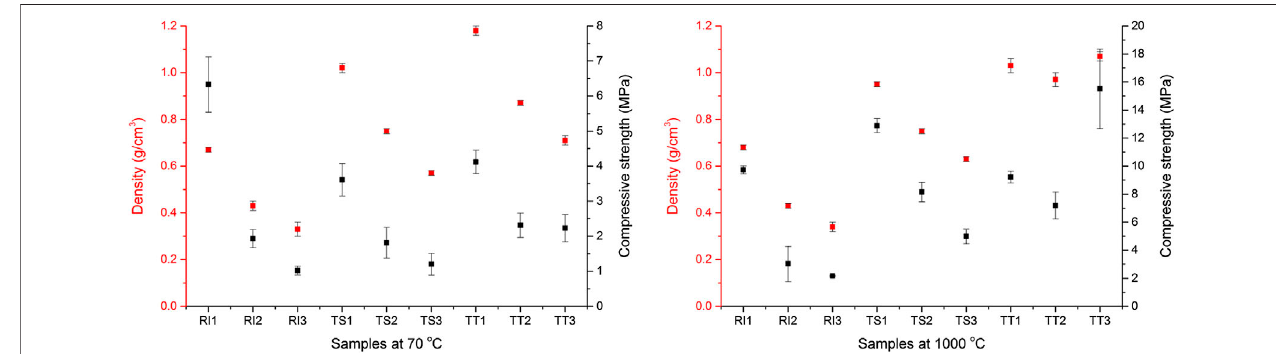
FIGURE 2 | Density and compressive strength of the alkali-activated foams investigated when cured at 70 ° C and thermally treated at 1,000 ° C.